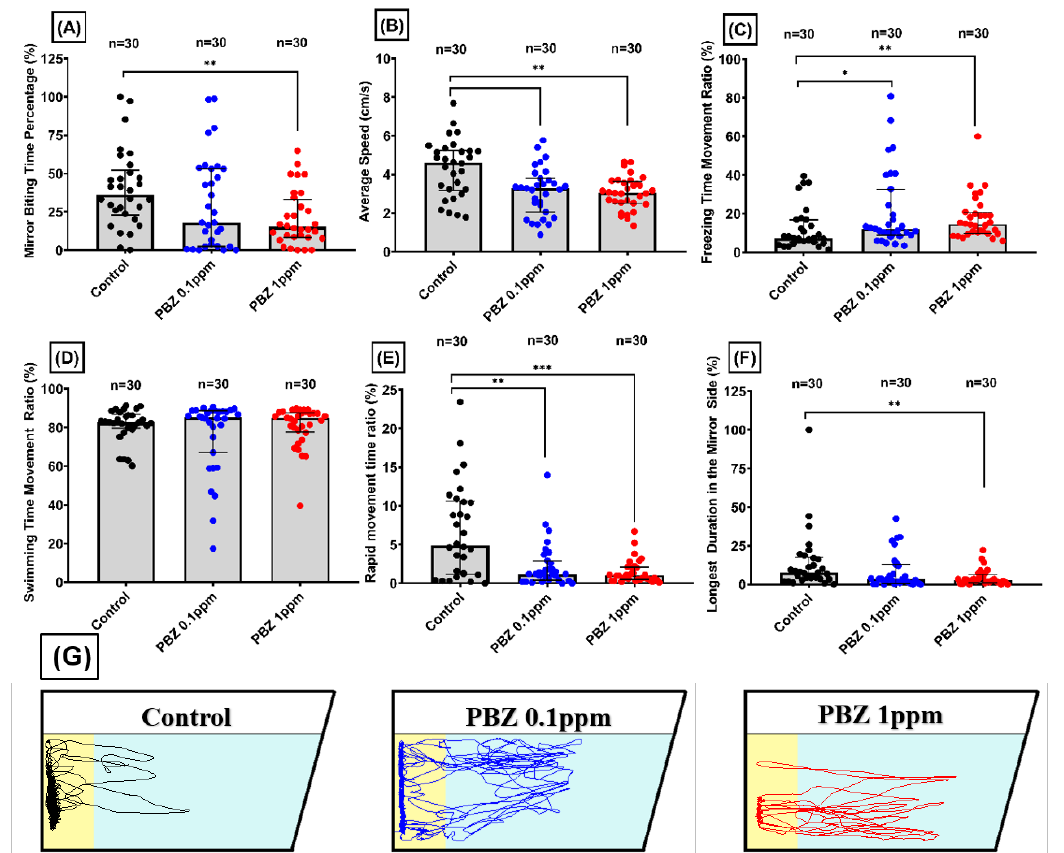
Figure 6. Aggressive behavior test for adult zebrafish after exposed to different doses of Paclobutrazol. Six behavioral endpoints were measured as: ( A ) mirror biting time, and ( B ) average speed of control and treatment group. ( C ) Freezing time ratio of all tested group, ( D ) swimming time movement ratio of all groups, ( D ) swimming time movement of all the group, ( E ) rapid movement ratio, and ( F ) duration of stay in the mirror side. ( G ) Trajectories of adult zebrafish in mirror biting assay after exposed to 0 (control), 100 µg/L (0.1 ppm), and 1000 µg/L (1 ppm) of Paclobutrazol (PBZ). The data are expressed as the means ± S.E.M. and were analyzed by the one-way ANOVA (* p < 0.05, ** p < 0.01, *** p < 0.001).